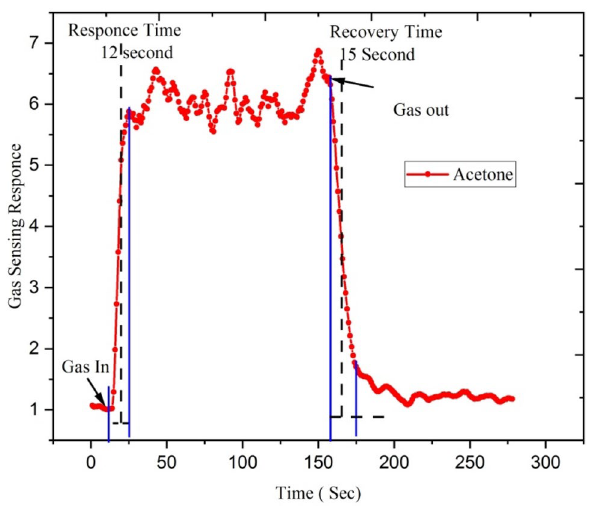
Figure 19. Response-recovery characteristics of the Ga-doped ZnO (Si 6+ ion irradiated at 5 × 10 13 ion fluence) thin film at the operating temperature 450 °C for 250 ppm concentration of acetone.